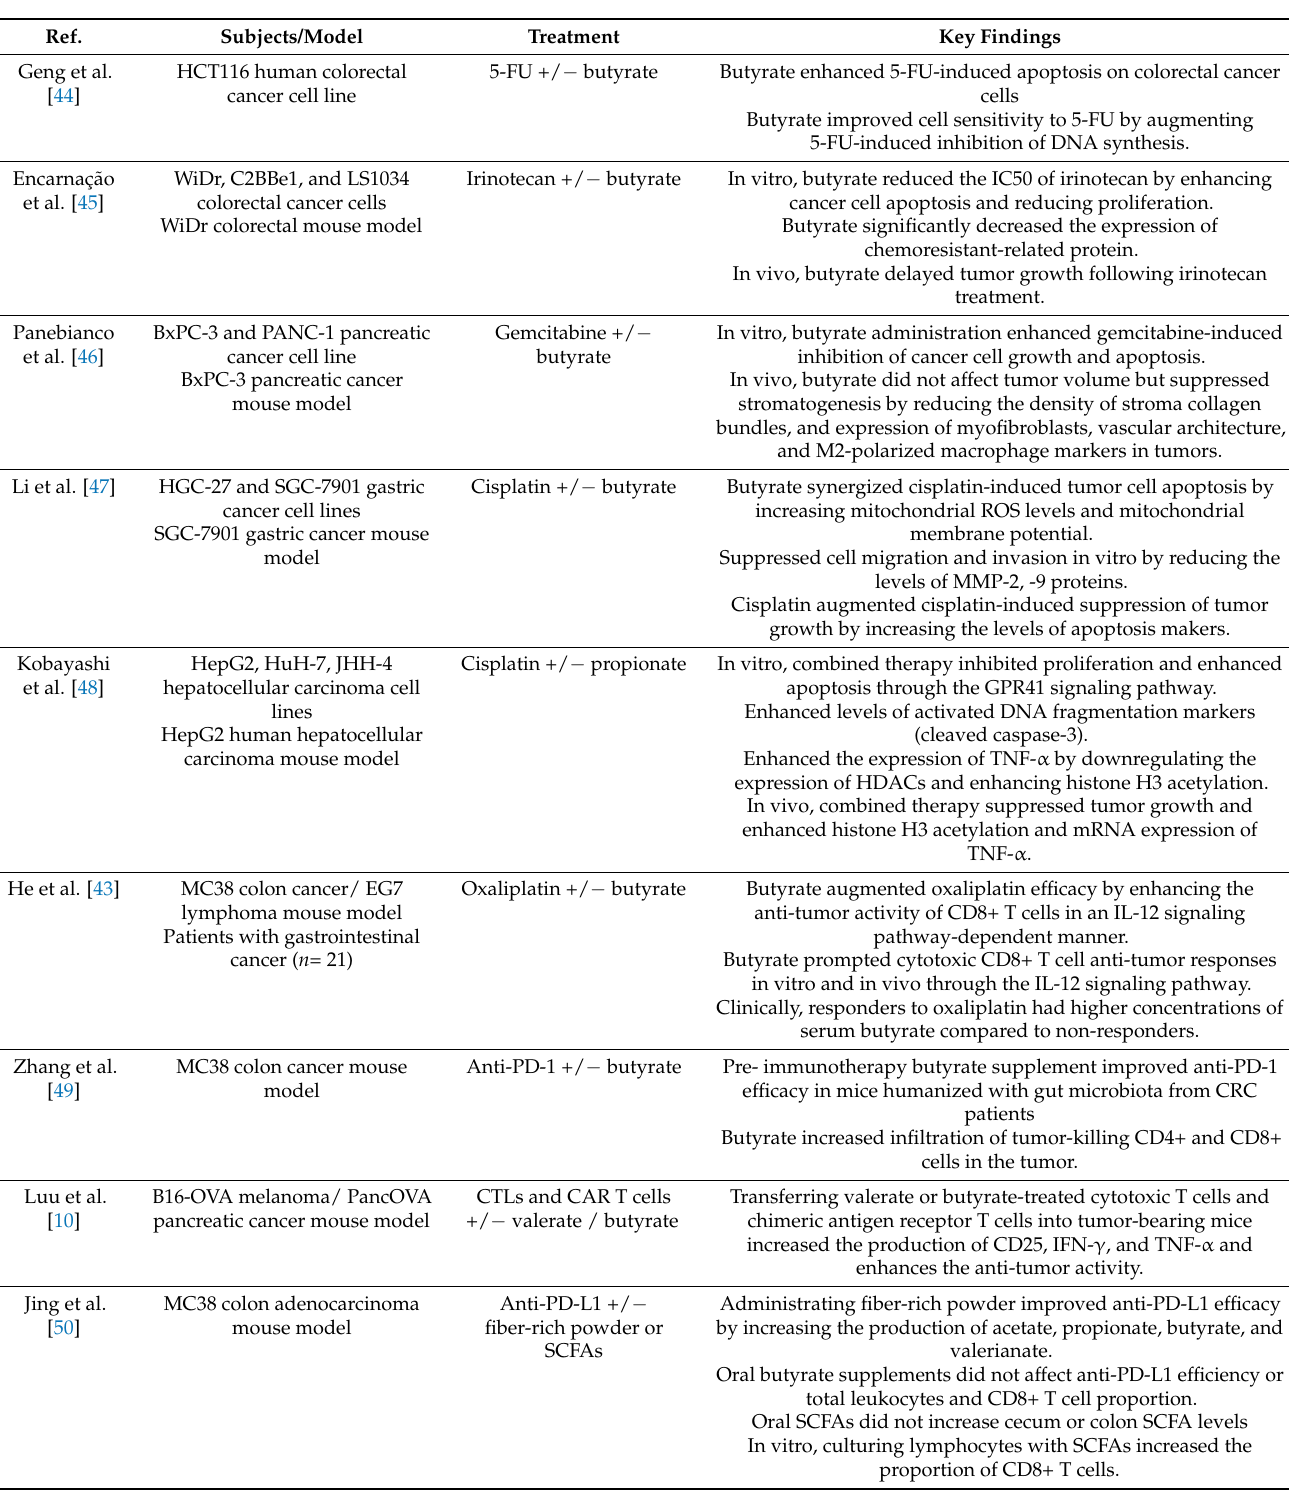
Table 1. Impact of SCFA-based interventions on cancer treatment anti-tumor